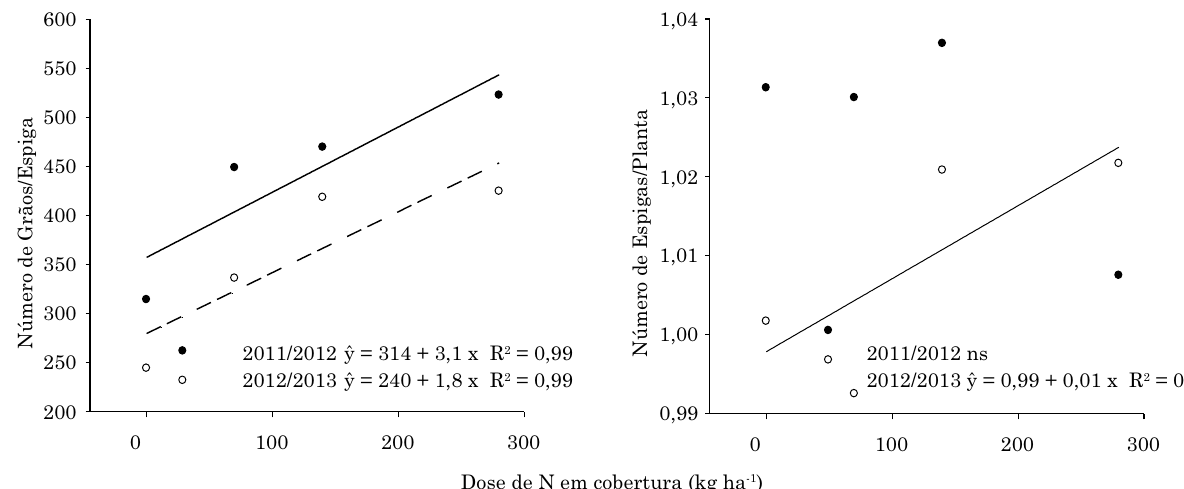
Figura 4. Número de grãos/espiga e número de espigas/planta do milho em função da aplicação de quatro doses e quatro fontes de N em cobertura - 2011/12 e